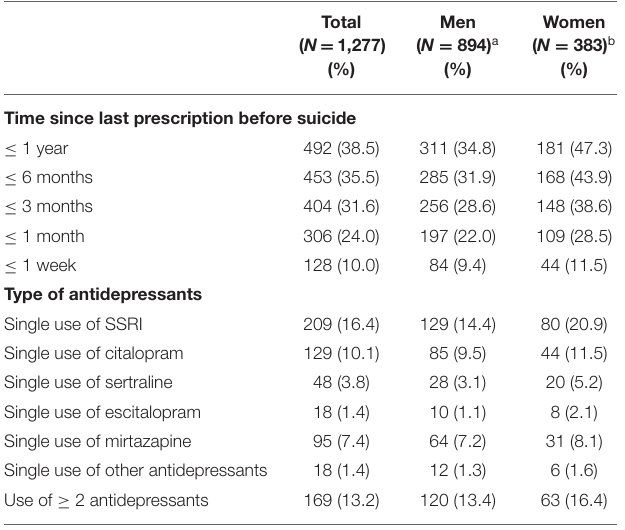
TABLE 2 | Distribution of suicide by exposure to and type of (non-tricyclic) antidepressant as well as time since the last antidepressant fill in persons aged 75 and above residing in Sweden between 2007 and